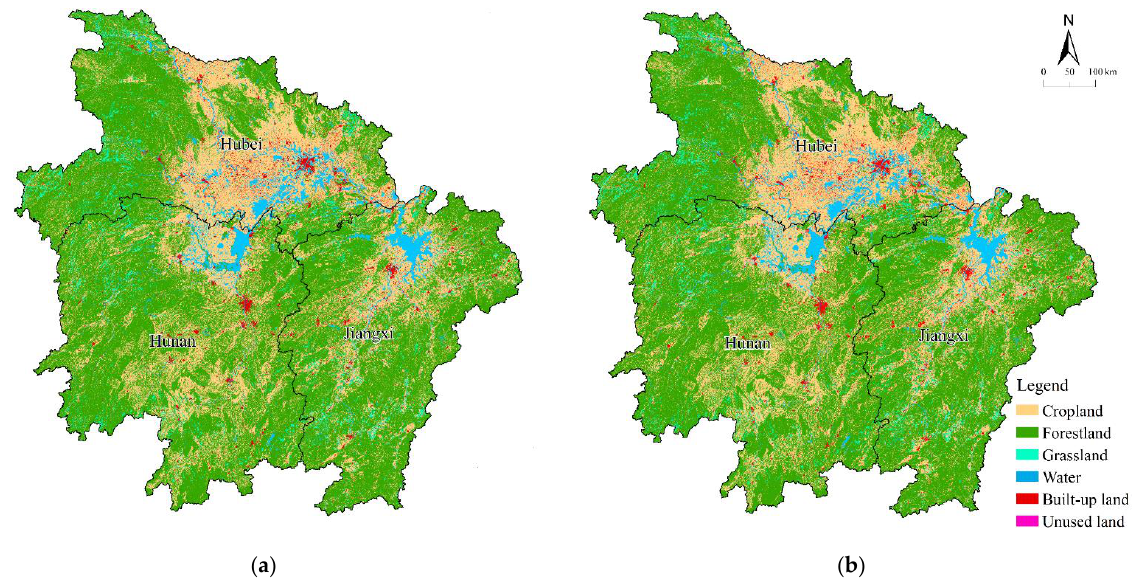
Figure 2. Real and simulated land-use maps of the MRYRR in 2010. ( a ) Real land use in the MRYRR according to official data in 2010. ( b ) Land use as simulated by the PLUS model based on data from 2005.